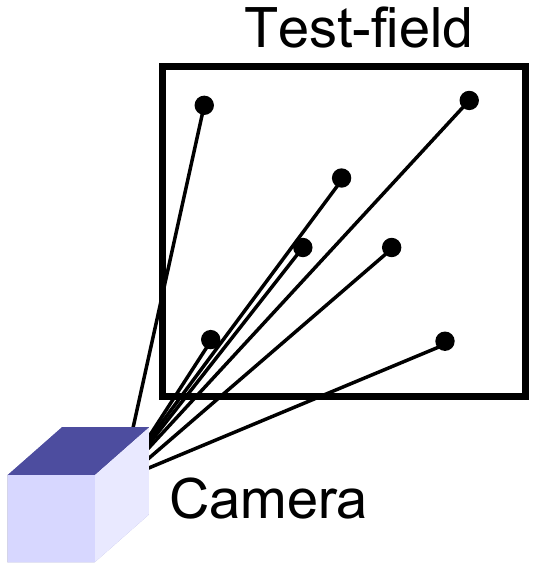
Figure 1: Schematic of the test-field calibration setup